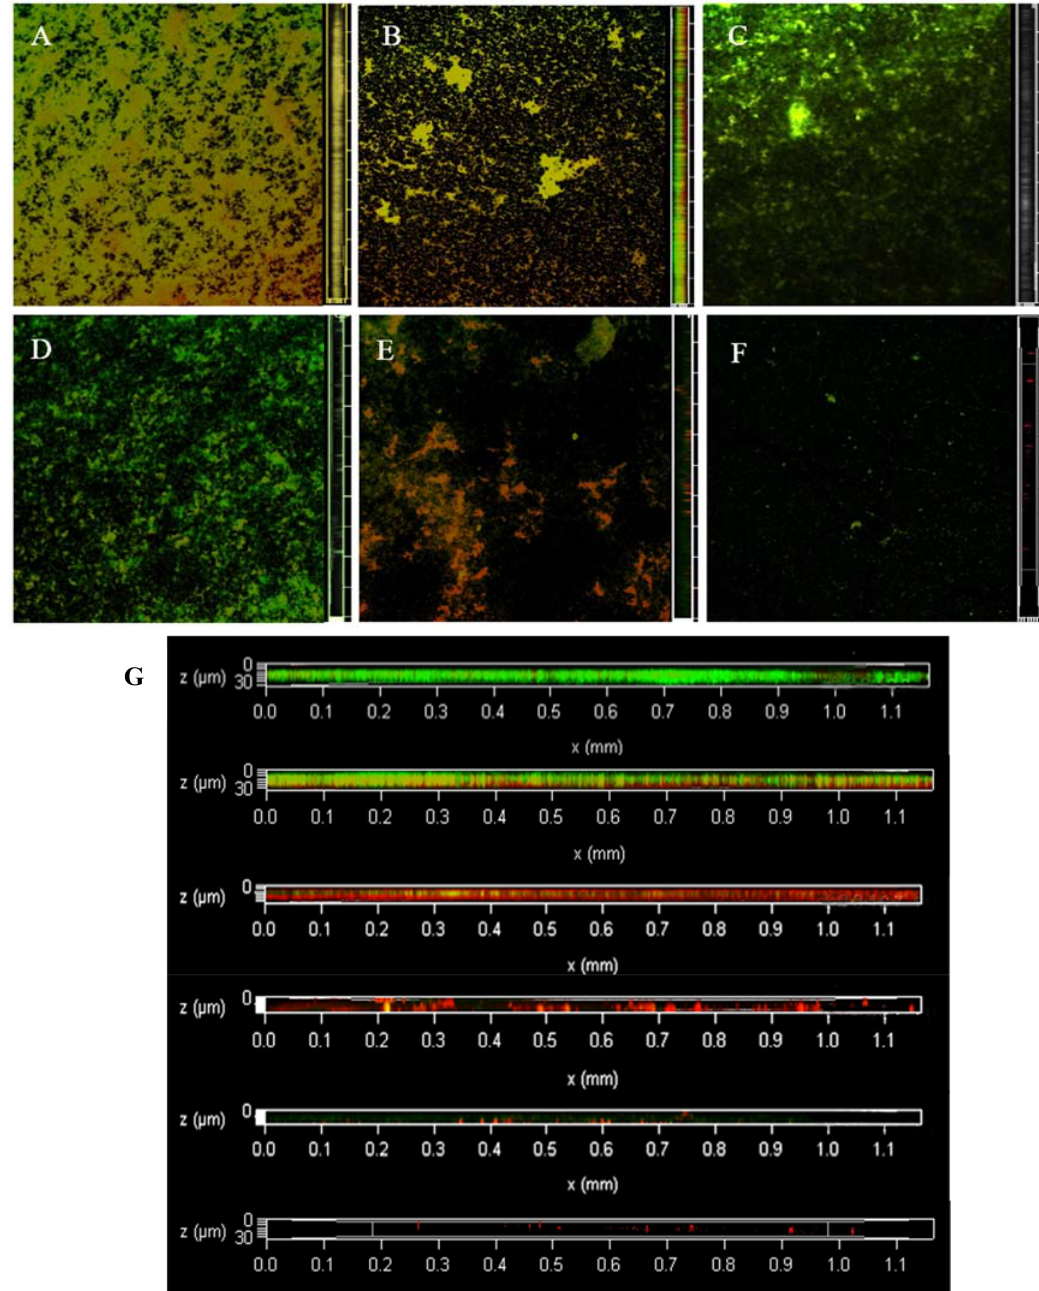
Figure 10. The changes of eDNA and eRNA in LM biofilm after NEHW treatment observed by CLSM; each sample randomly selects three visual fields. Images include front and side views of the biofilm under CLSM. Scale bar—100 µ m. ( A – F ) represent treatment times of 0, 2, 4, 6, 8, and 10 min, respectively. ( G ) is an enlarged version of all the images on the right and is also a right-hand view of the biofilm, from top to bottom, for SAEW treatments 0, 2, 4, 6, 8 and 10 minutes respectively. NEHW was the abbreviation of non ‐ electrolytic hypochlorite water.